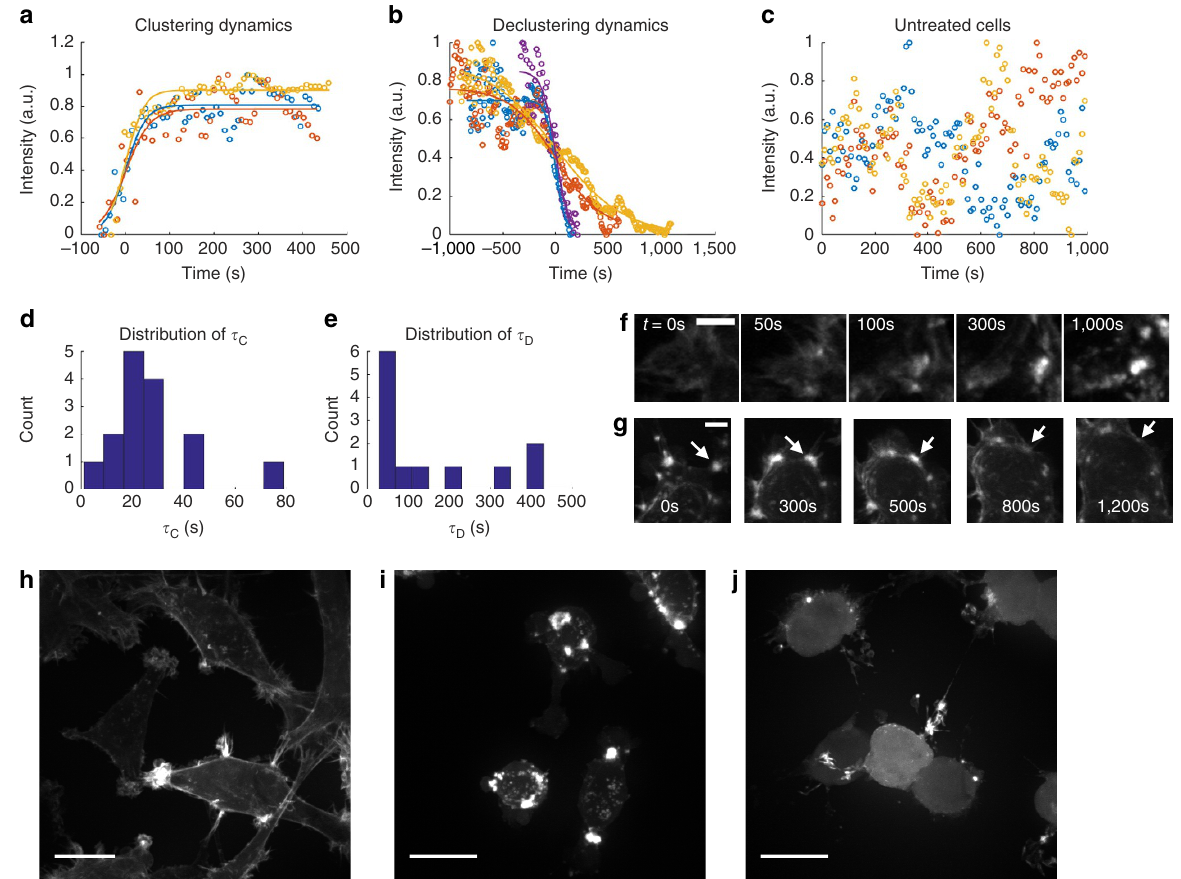
Figure 7 | Clustering dynamics in living cells. ( a ) Representative data (open circles) and fits (curves) of the normalized intensity of fluorescent F-actin in cells during ( a ) clustering after Cytochalasin D treatment, ( b ) declustering after washing out Cytochalasin D and ( c ) normal conditions for untreated cells. For a , b , curves and data are shifted on the time axis by the time delay offset (see Methods) such that the fitted sigmoid is centred at t ¼ 0. The condition of the media was initially changed to Cytochalasin D or washed and replenished with growth media for a , b , respectively, at the first time point of each data set. Different colours represent different representative clusters or intracellular positions across multiple cells. Distributions of time constants for ( d ) clustering (average t C ¼ 28 ± 5s (s.e.m.), n ¼ 15 clusters) and ( e ) declustering (average t D ¼ 155 ± 42s (s.e.m.), n ¼ 12 clusters). Representative time evolution during cluster ( f ) formation and ( g ) disintegration inside live cells. In f , g , t ¼ 0 corresponds to the time when the drug is added or removed. Scale bars, 5 m m. Arrows point to the same cluster at different time points. Typical cells that are ( h ) untreated, ( i ) treated with Cytochalasin D for 1h, and ( j ) treated with Latrunculin A for 1h. Images in h – j are maximum projections from z-stacks with 1 m m z-resolution. Scale bars, 20 m